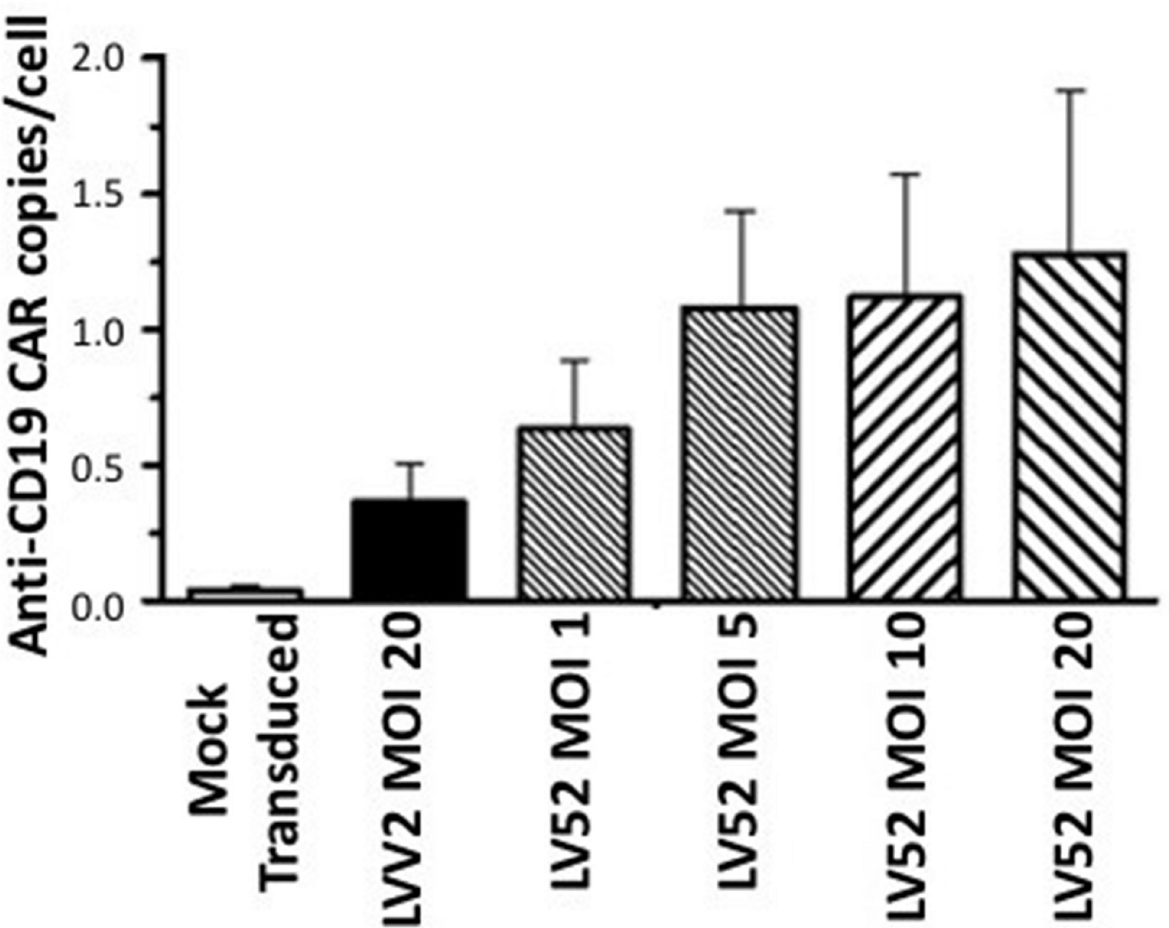
Fig 3. Efficacy of transduction of T cells with anti-CD19 CAR. PBMCs were mock transduced or transduced with LVV2 or LV52 lentiviral vectors using a range of MOI as indicated. Cells were assessed for anti-CD19 CAR expression using qPCR, and the number of transgene copies was expressed as the average number detected in each cell. Bars indicate the mean ± SEM of 3 independent experiments.